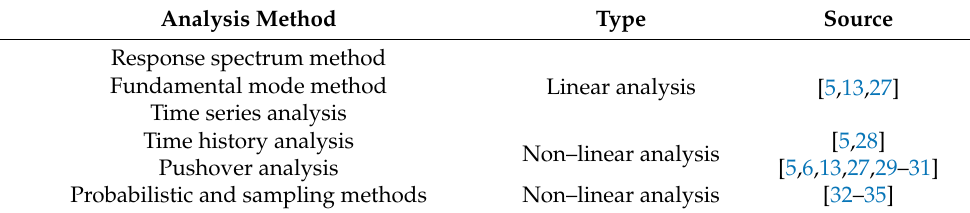
Table 1. List of the most commonly used methods for seismic analysis of existing road